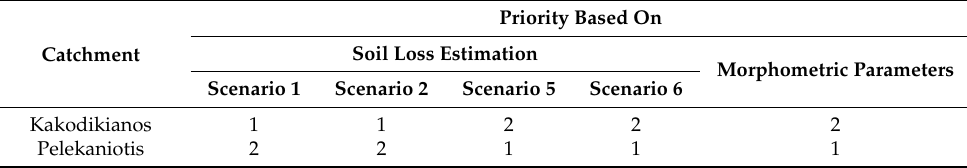
Table 16. Priority based on soil loss estimation and morphometric parameter